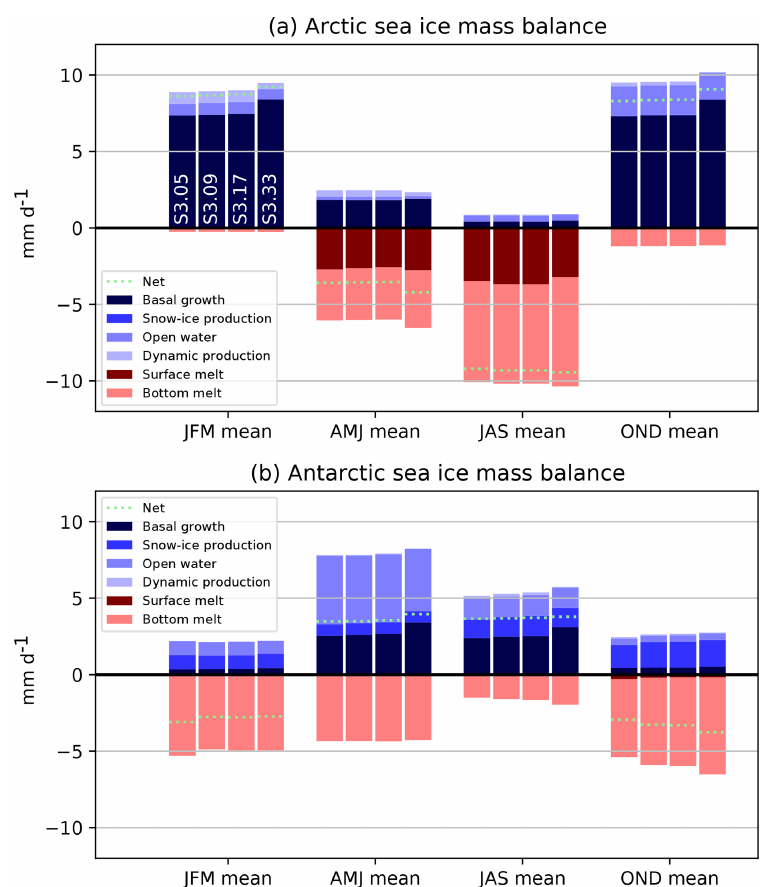
Figure A3. Contributions to the seasonal mass balance of Arctic (a) and Antarctic (b) sea ice as simulated in the third set of sensitivity experiments (S3) (refining the ITD within a fixed set of categories), averaged over the areas depicted in Fig. A1. Blue colors refer to processes that contribute to positive ice volume changes, while red colors indicate processes implying negative ice volume changes. The name of the experiments is indicated in the upper panel for the January–February–March season.